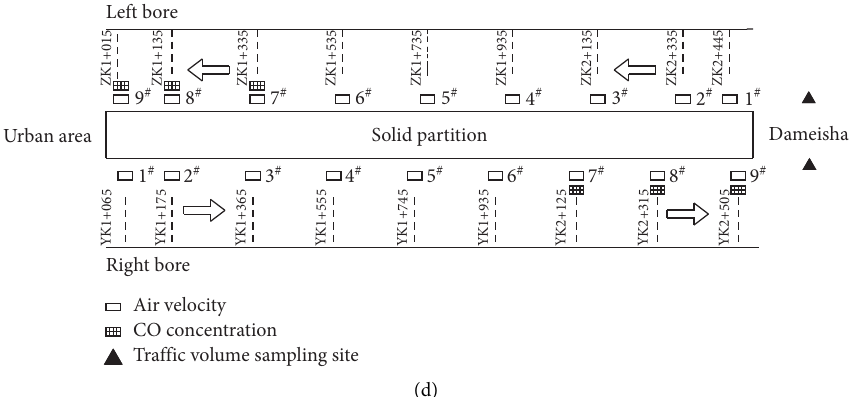
Figure 3: The sampling point distribution in the four tunnels. (a) Henglongshan Tunnel. (b) Cejiexian Tunnel. (c) Jiuweiling Tunnel. (d) Dameisha